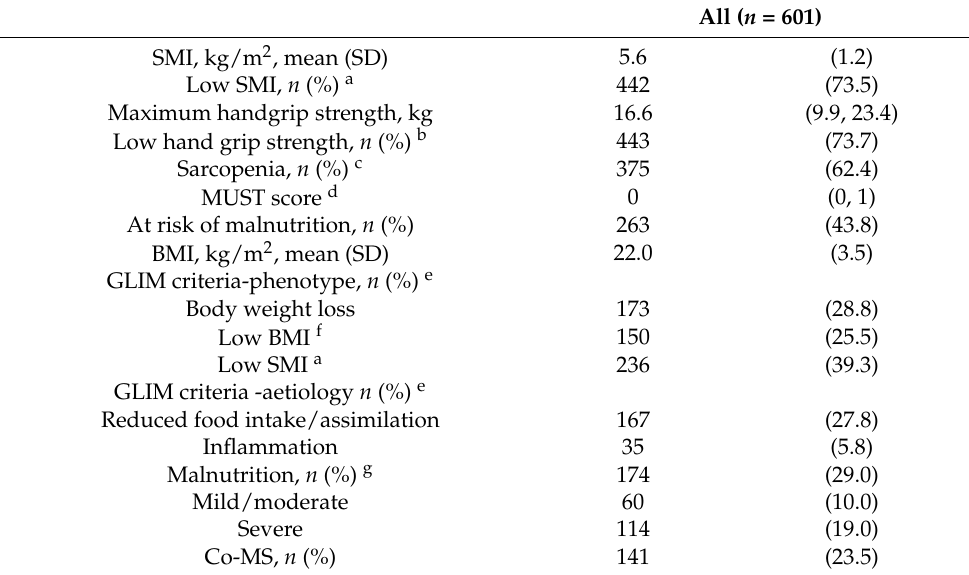
Table 2. Prevalence of malnutrition, sarcopenia, and coexistence of malnutrition and sarcopenia